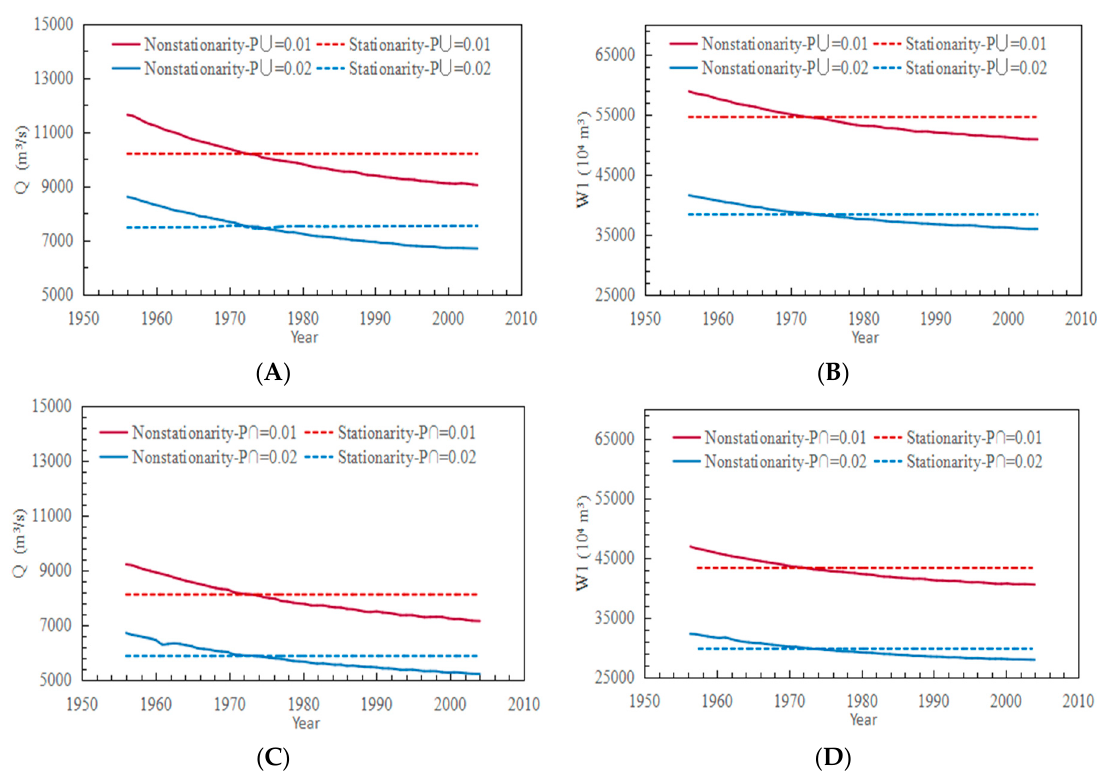
Figure 6. Results of the most likely design events (combinations of flood peak and volume). Case illustration for P ∪ = 0.02, 0.01 ( A , B ) and P ∩ = 0.02, 0.01 ( C , D